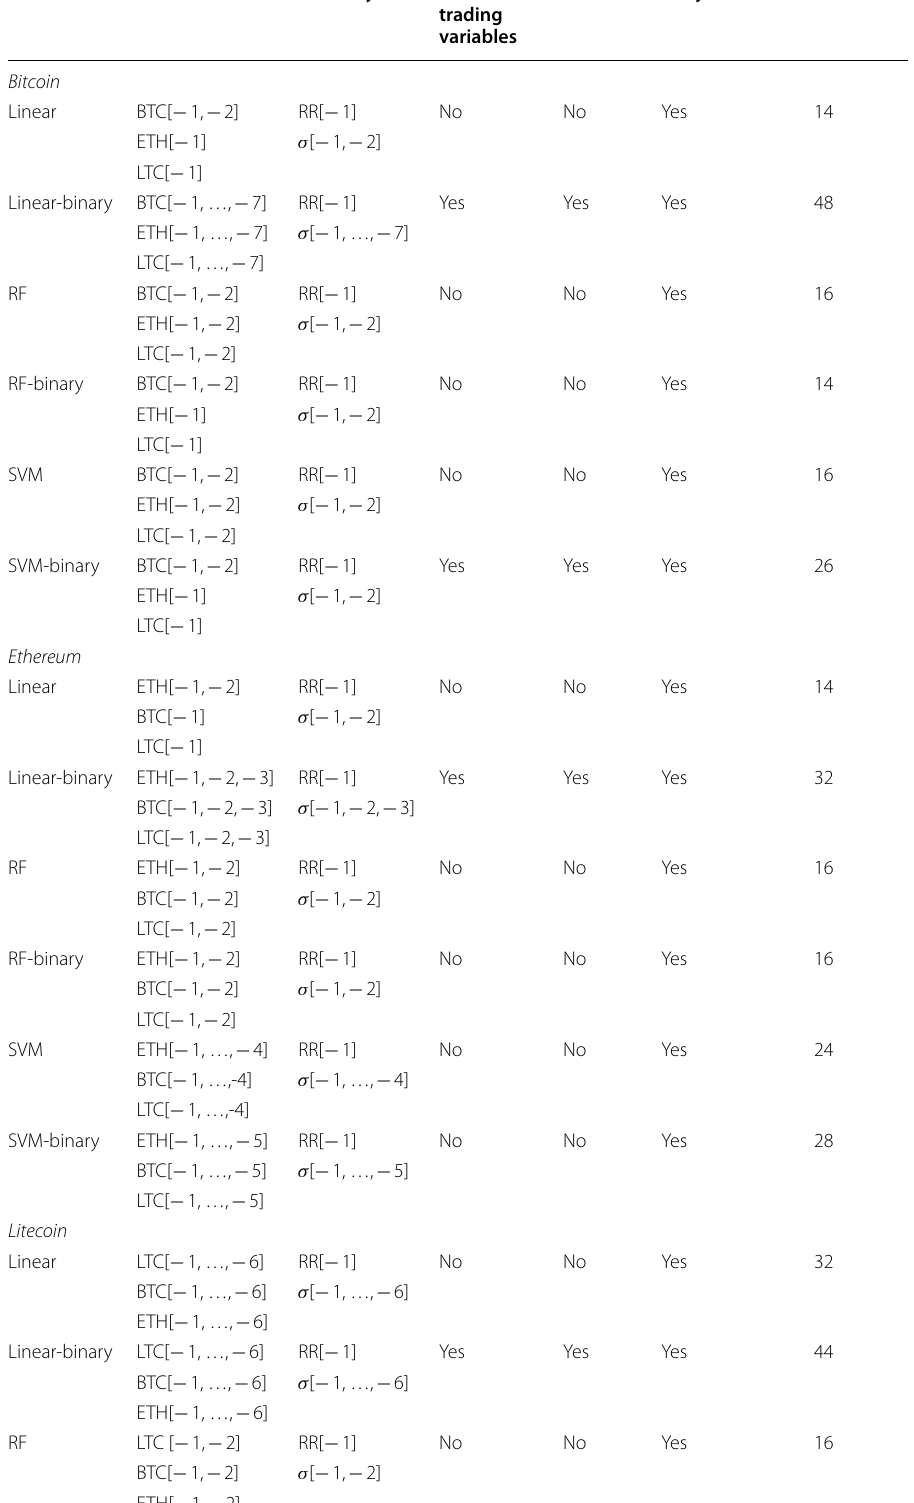
Table 5 Sets of variables used in the models Variables Returns Volatility Other